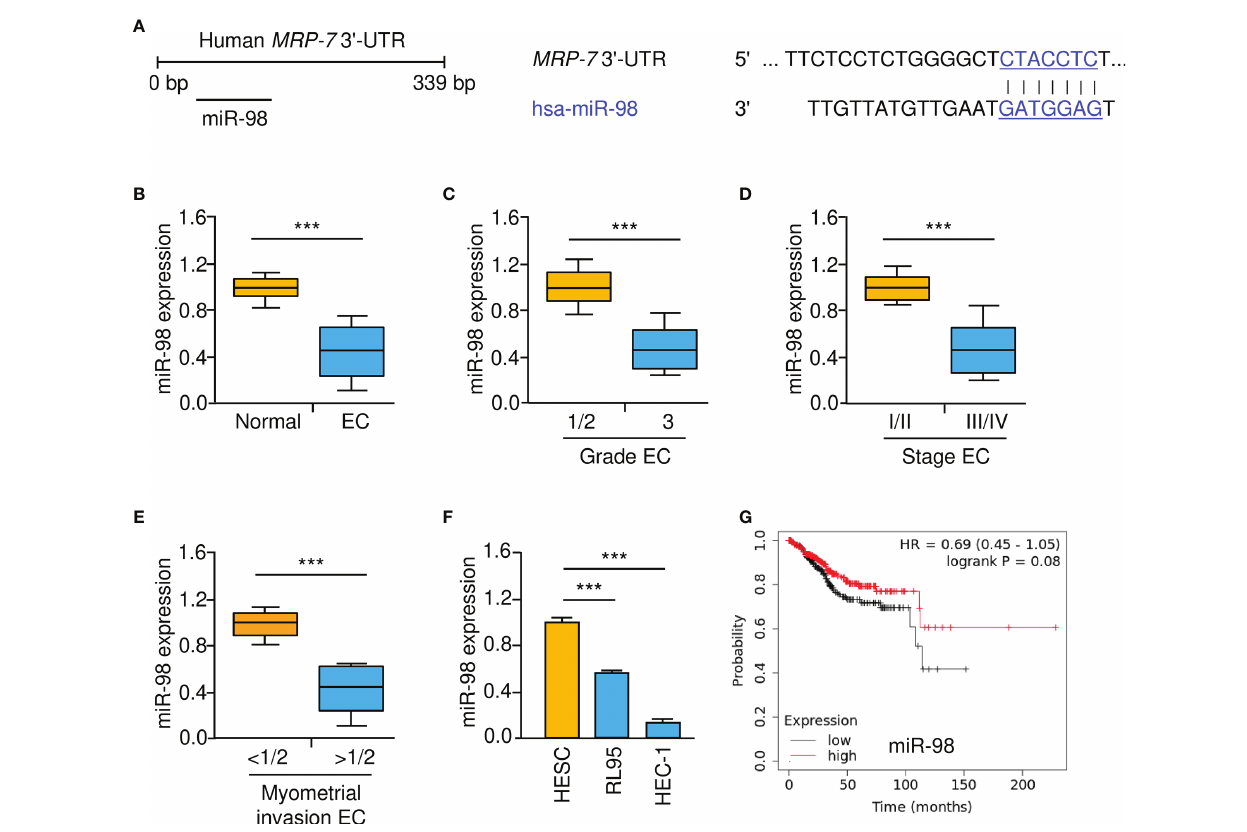
FIGURE 5 | Lower MiR-98 Levels are Correlated with Worse Prognosis in EC. (A) Schematic representation of the predicted binding between MRP-7 3 ′ -UTR sequence and miR-98 (TargetScan database). (B) The expression of miR-98 in EC and normal tissues were examined using qRT-PCR assays. (C – E) MiR-98 levels were signi fi cantly decreased in EC patients with advanced tumors (C) , late-stage disease (D) , or deeper myometrial invasion (E) . (F) EC cells have a much lower expression of miR-98 than normal HESC cells. (G) The relationship between miR-98 expression and the overall survival of EC patients (KM plotter database). *** P <